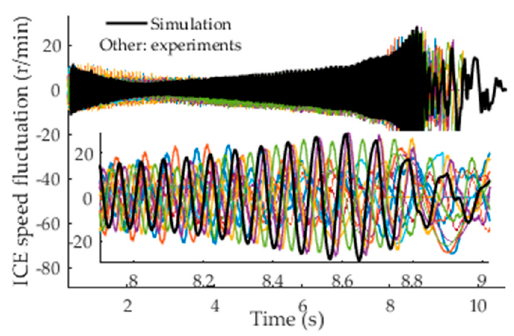
Figure 12. Engine speed fluctuations during stopping.